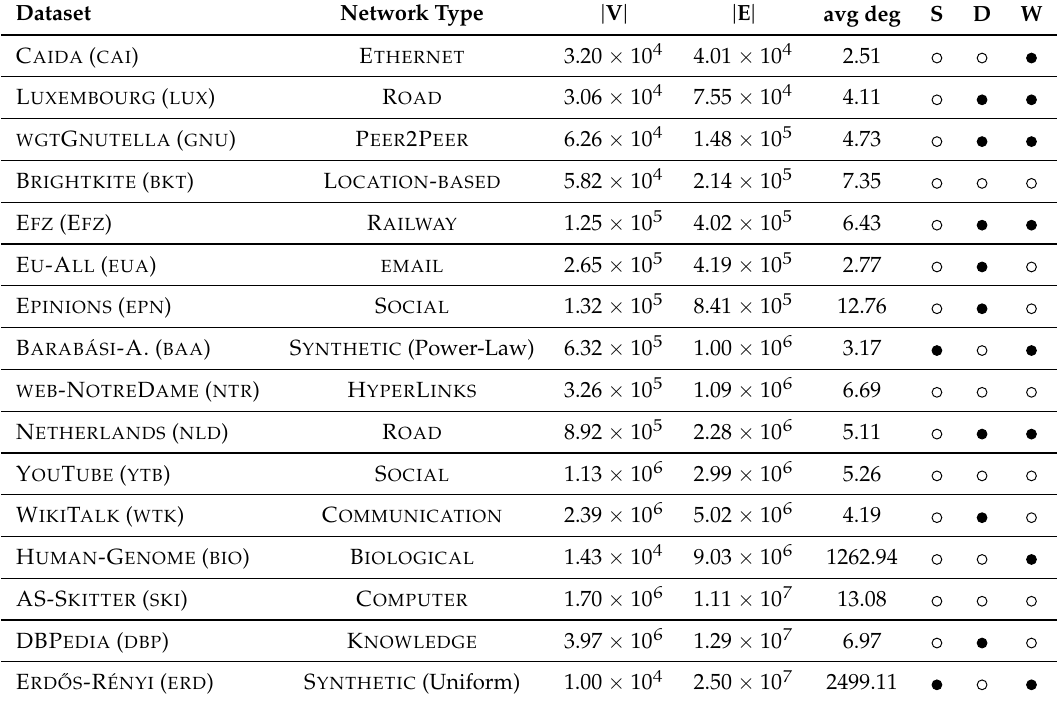
Table 1. Overview of the used input graphs. The first and second columns reports name of the dataset and type of the corresponding network. Third and fourth columns show number of vertices and arcs of the graph, while the fifth column reports the average vertex degree. The last three columns, namely S , D , and W , respectively, indicate whether the graph is synthetic or real-world and whether it is directed/weighted or not, respectively ( = true, = false). Graphs are ordered according to their number of arcs,